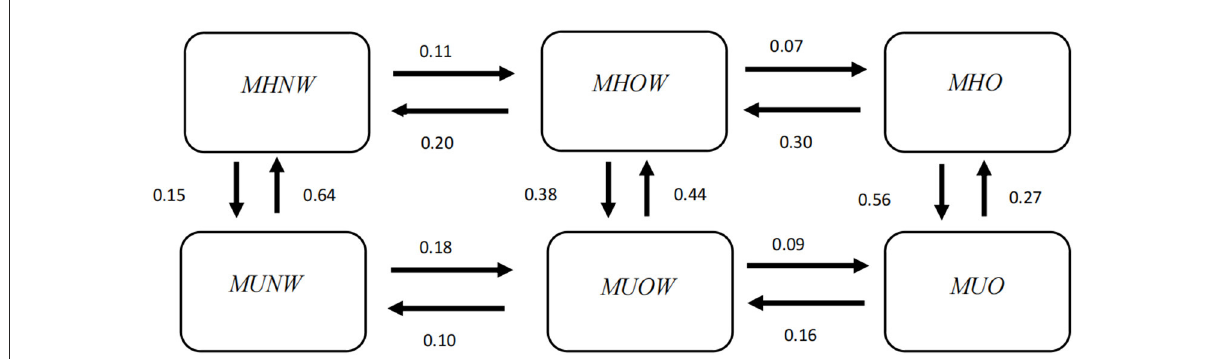
FIGURE2 Transition intensity from one phenotype to another estimated by the multistate Markov model. MHNW, metabolically healthy normal weight; MHOW, metabolically healthy overweight; MHO, metabolically healthy obesity; MUNW, metabolically unhealthy normal weight; MUOW, metabolically unhealthy overweight; MUO, metabolically unhealthy obesity.